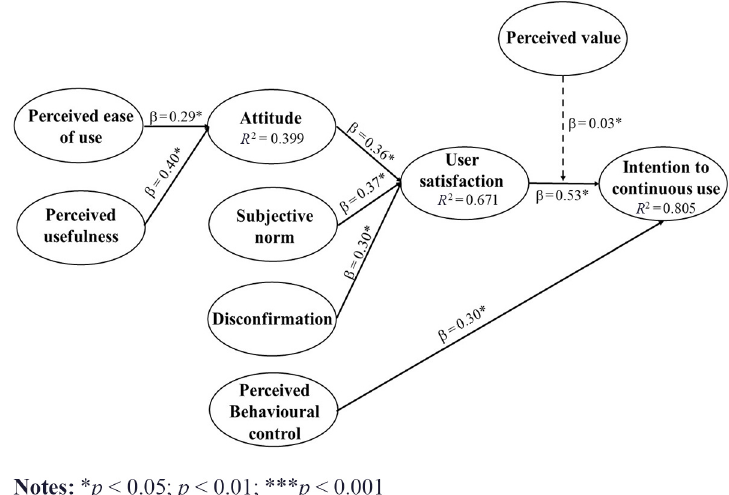
Figure 2. Results of the path coef fi